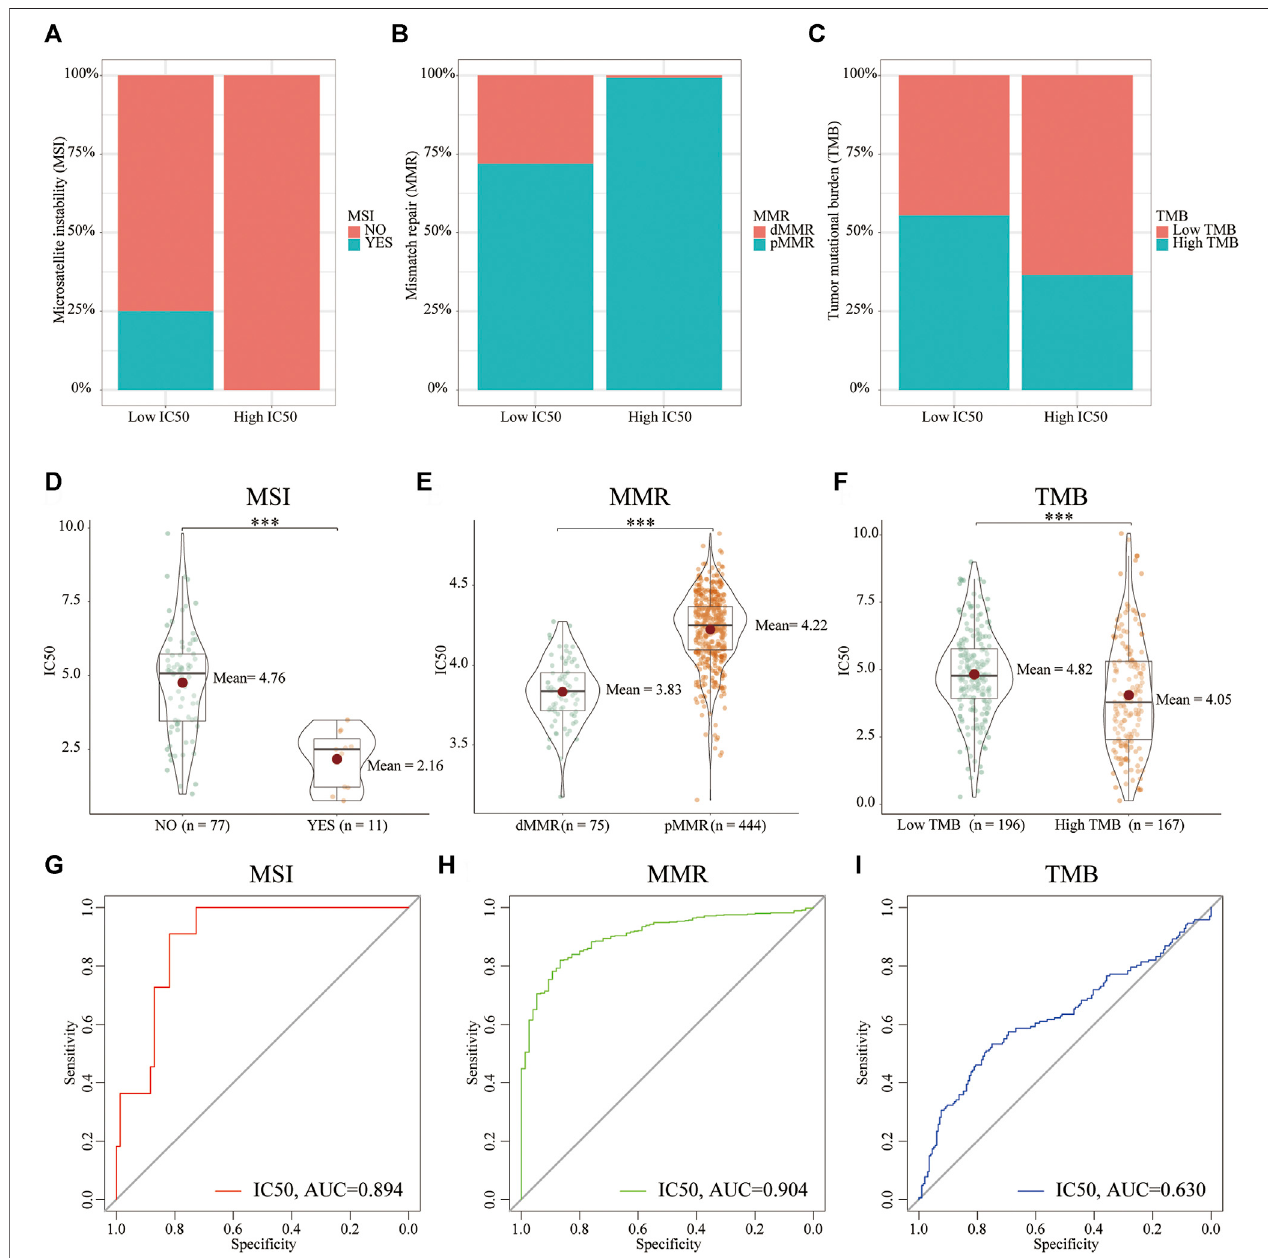
FIGURE 4 | The relationship between hallmarks of genomic instability and IC50. Compared with the high-IC50 group, the low-IC50 group had a higher proportion of (A) MSI, (B) dMMR, and (C) more TMB. CC patients in the (D) MSI, (E) dMMR, (F) high TMB group had signi fi cantly lower IC50 for cisplatin chemotherapy. The IC50 had excellent diagnostic performance for (G) MSI and (H) dMMR,= and (I) general diagnostic performance for TMB. *** p < .001.